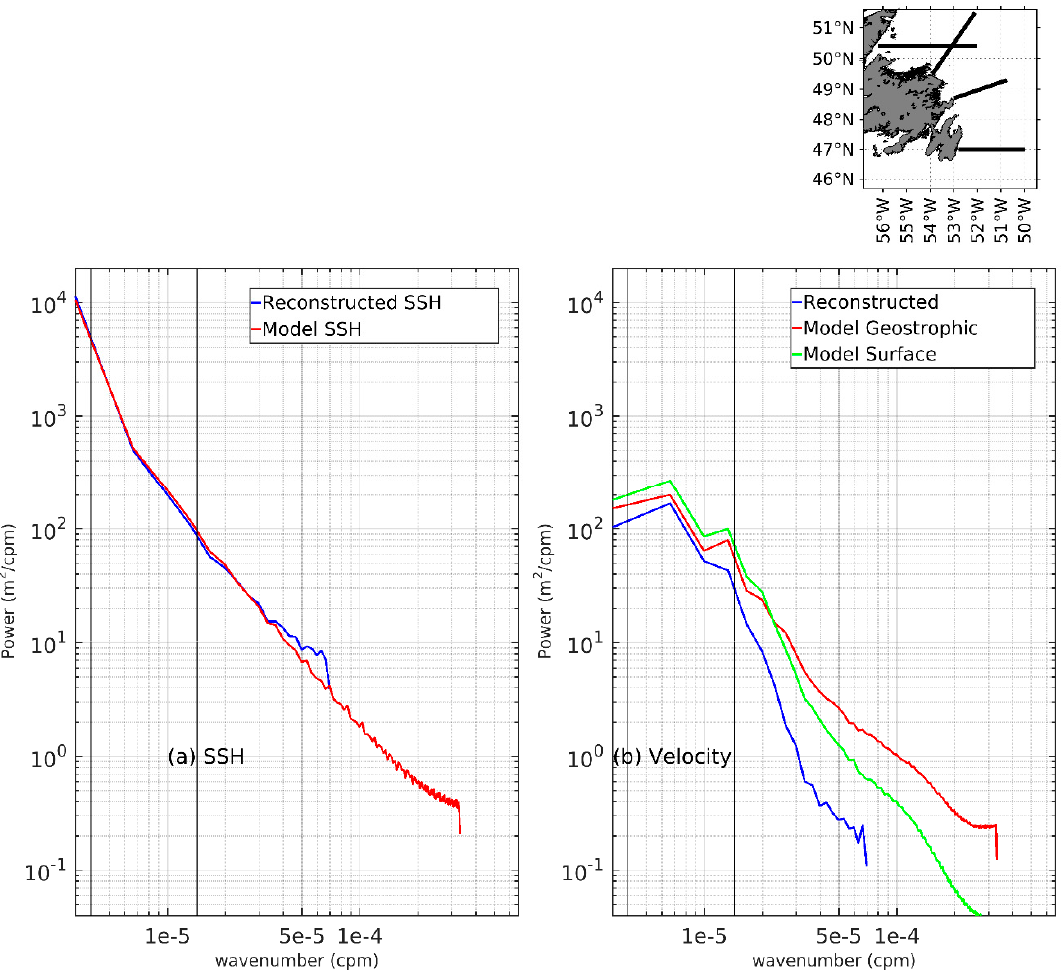
Figure 8. Wavenumber spectrum ( a ) of mapped SSH (blue lines) and model (red lines) and ( b ) of the mapped SSH-derived geostrophic surface current (blue lines), model SSH-derived ones (red lines), and model surface current (green lines) averaged over the four transects. The areas between two black lines indicate mesoscale band (70 to 250 km) defined as in [25–27].